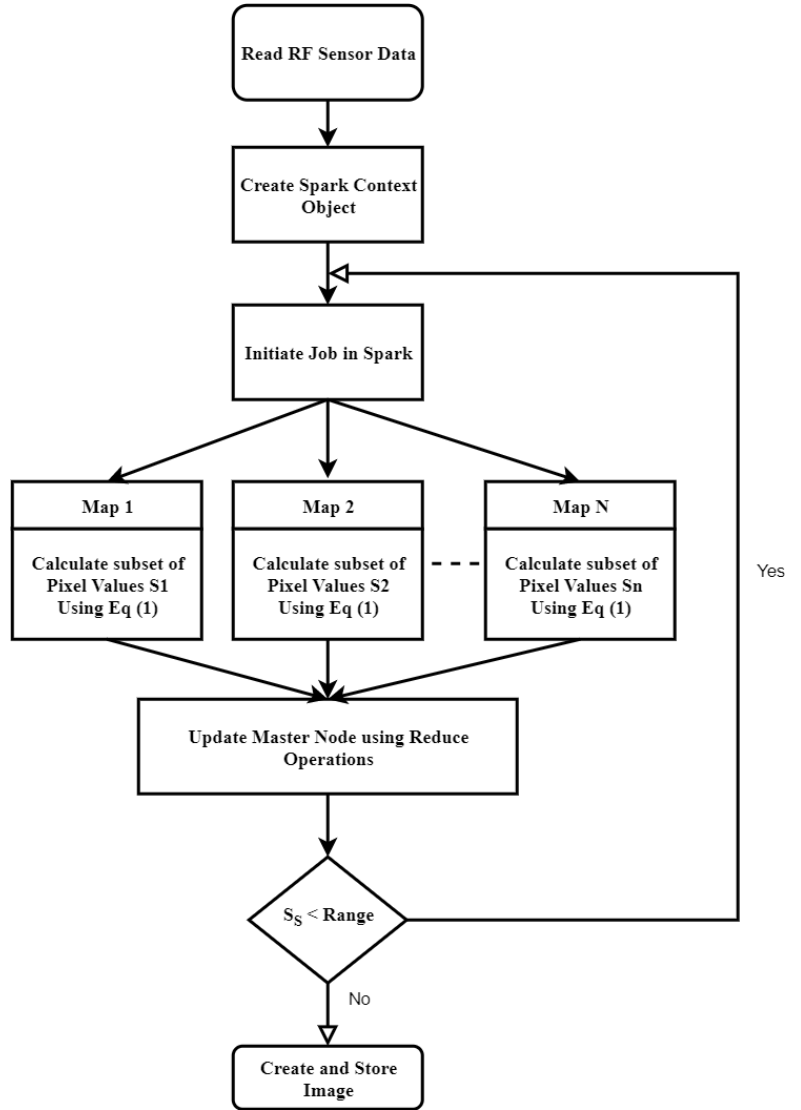
Figure 3. The parallelism of the microwave image reconstruction (MIR) algorithm. RF = radio